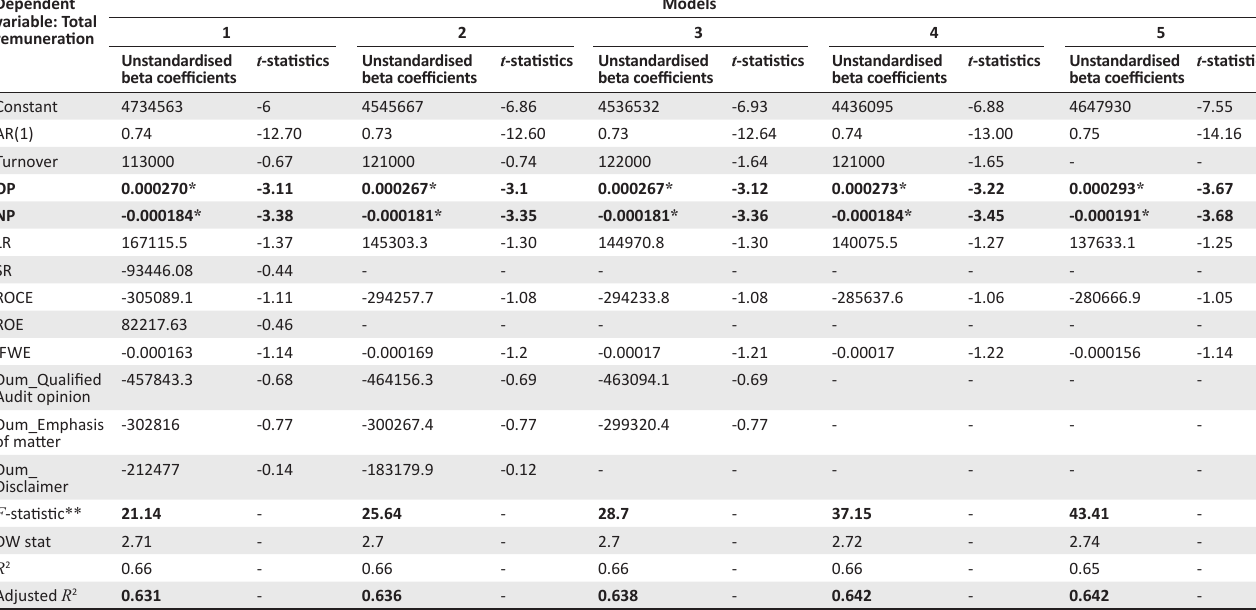
TABLE 8: Regression: Total remuneration and company performance